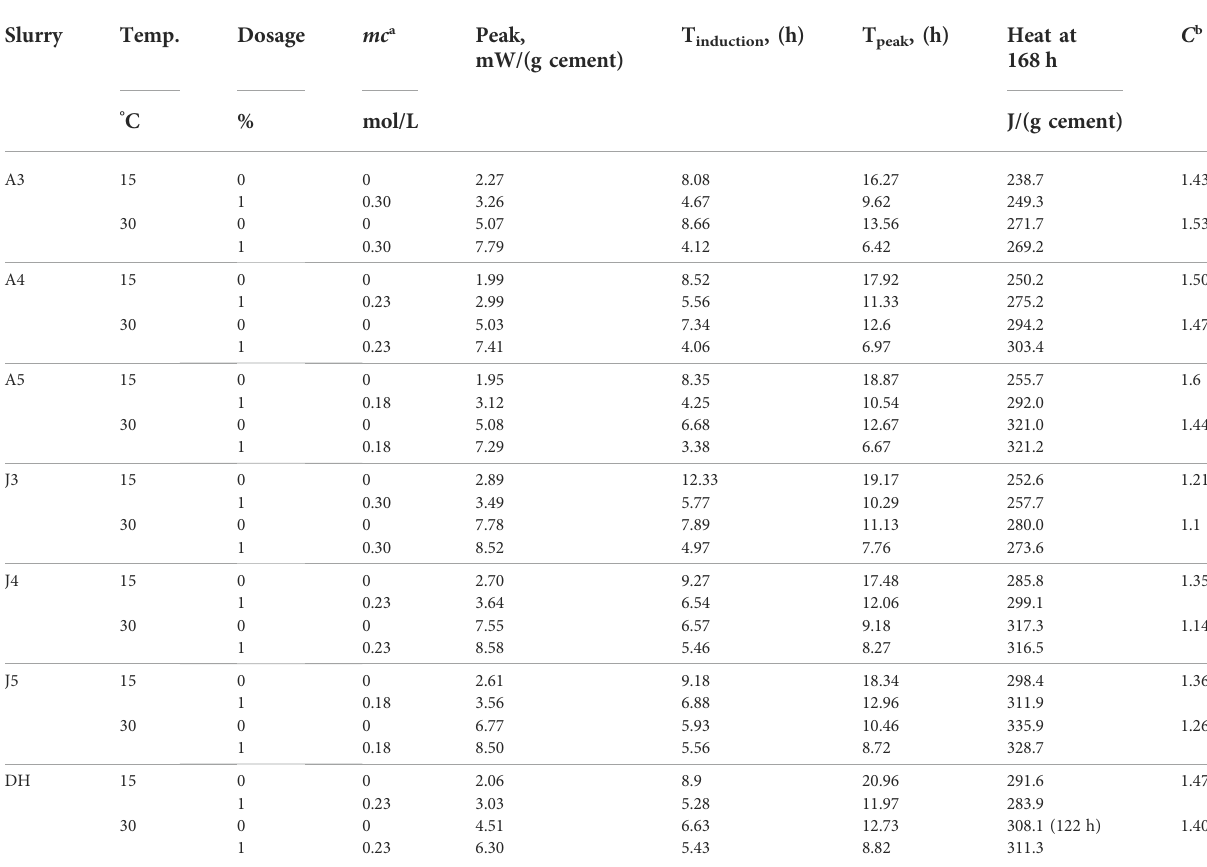
TABLE 4 In fl uence of CaCl 2 dosage on kinetic parameters of hydration for Class G cement. Slurry